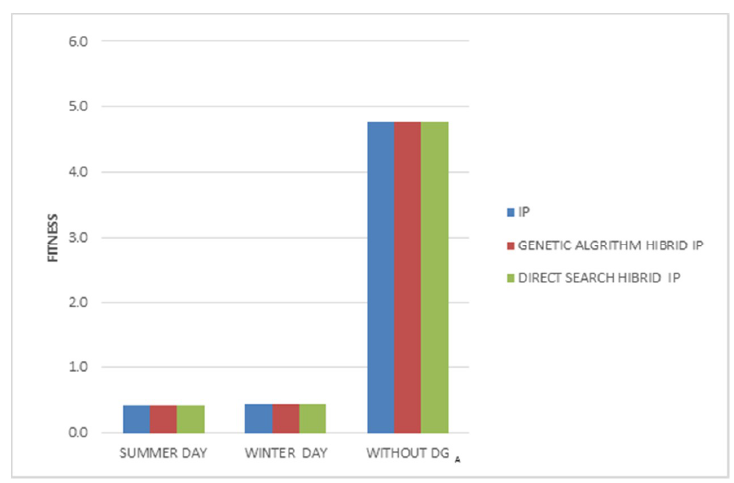
Figure 15. Fitness function values for the proposed methods.